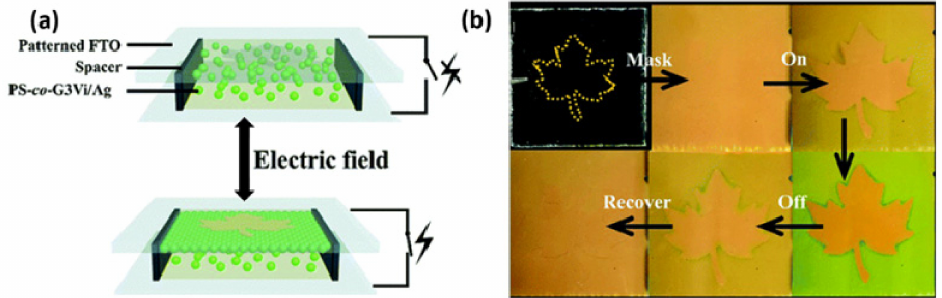
Figure 12. Invisible colloidal PC pattern shown by an electric field. ( a ) Schematic diagram showing the structure of an invisible patterned photonic anti-counterfeiting device. ( b ) The optical images showing that the anti-counterfeiting device can be reversibly displayed and hidden with the application and removal of an electric field. Reused with permission from Reference [14], Copyright 2016, The Royal Society of